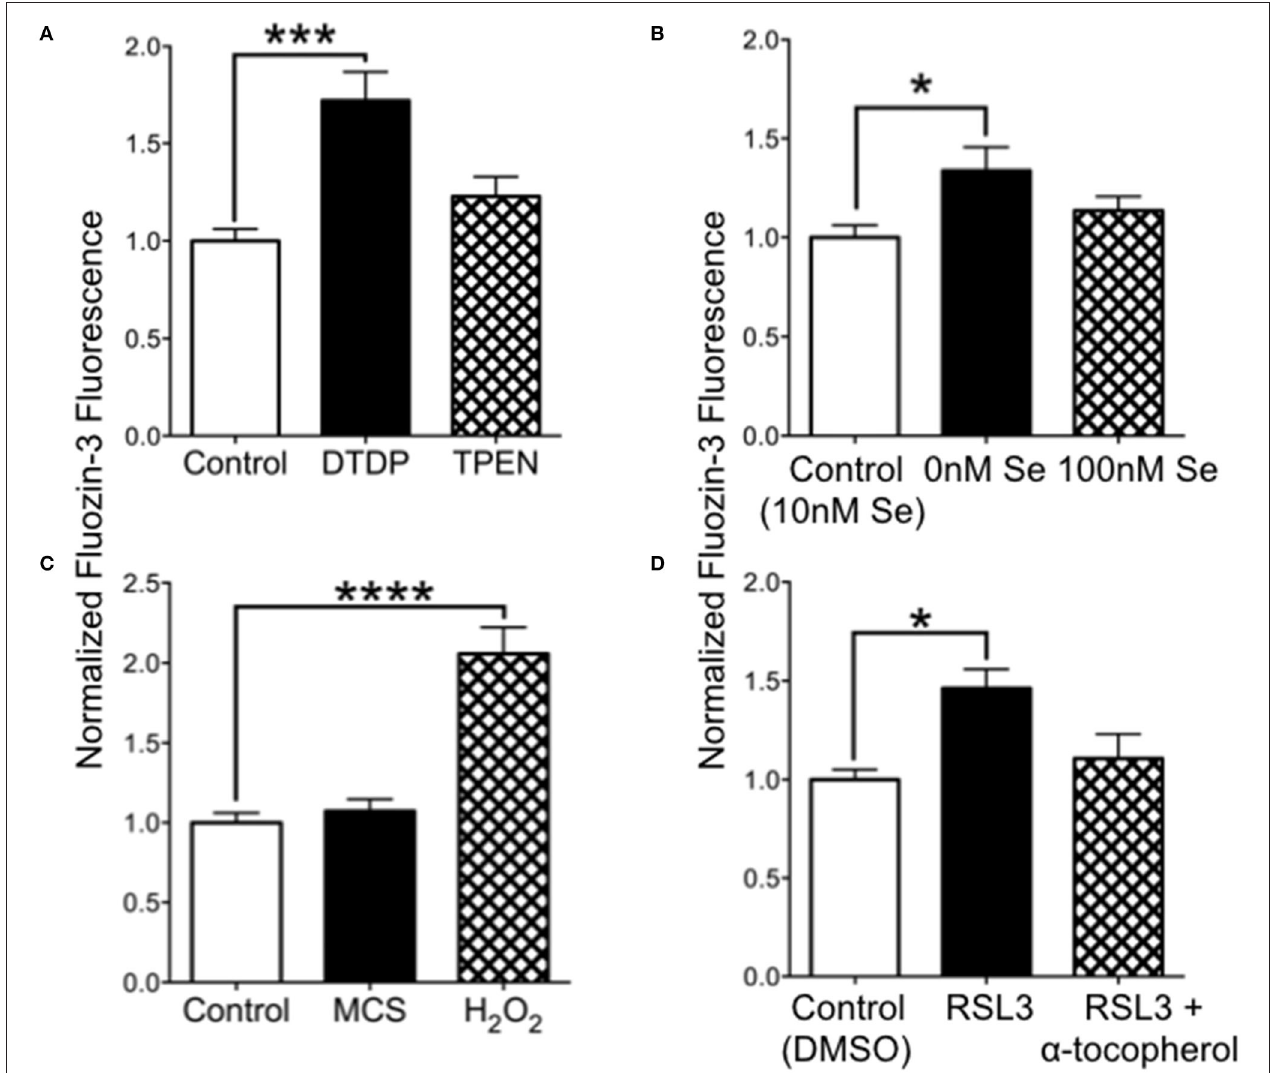
FIGURE 5 | Intracellular Zn 2 + levels are increased by 0 Se and GPX4 inhibitor RSL-3. (A) Relative FluoZin-3 fluorescence of SH-SY5Y cells. Cells exposed to DTDP to release zinc showed increased fluorescence, while cells exposed to PTEN to reduce intracellular zinc had no change in fluorescence. (B) FluoZin-3 fluorescence was increased in cells grown in media with 0nM Se relative to control media (10nM), while 100nM Se did not alter intracellular zinc. (C) Hydrogen peroxide but not GPX1 inhibitor mercaptosuccinate (MCS) increase intracellular zinc. (D) The GPX4 inhibitor RSL-3 increased intracellular zinc, which was reversed when RSL-3 was added with α -tocopherol. Statistical analysis is performed by one-way ANOVA followed by Dunnett’s multiple comparison test. * p < 0.05, *** p < 0.005, **** p <